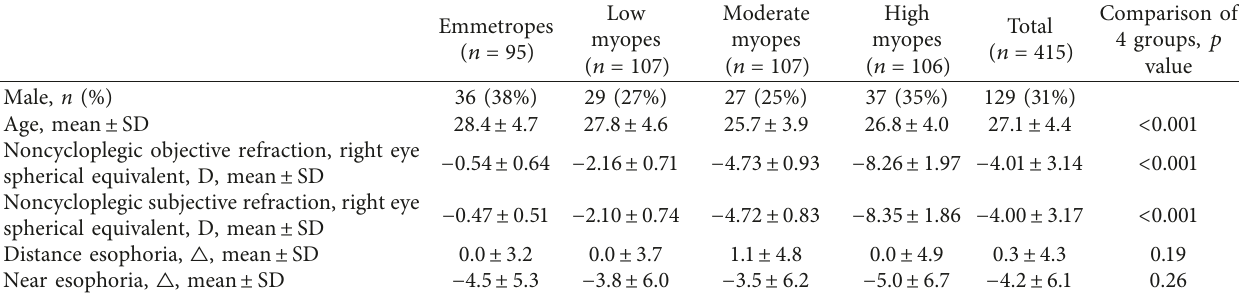
Table 2: Baseline